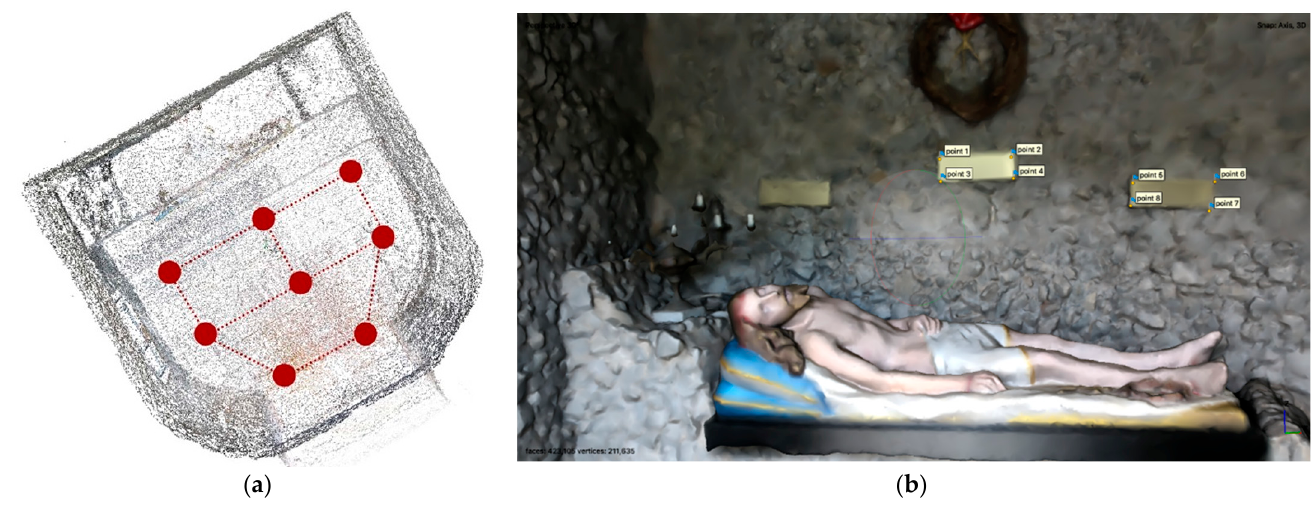
Figure 6. ( a ) Map of the photogrammetric acquisition. ( b ) The vertex colour mesh model of the inside of the sepulchre.